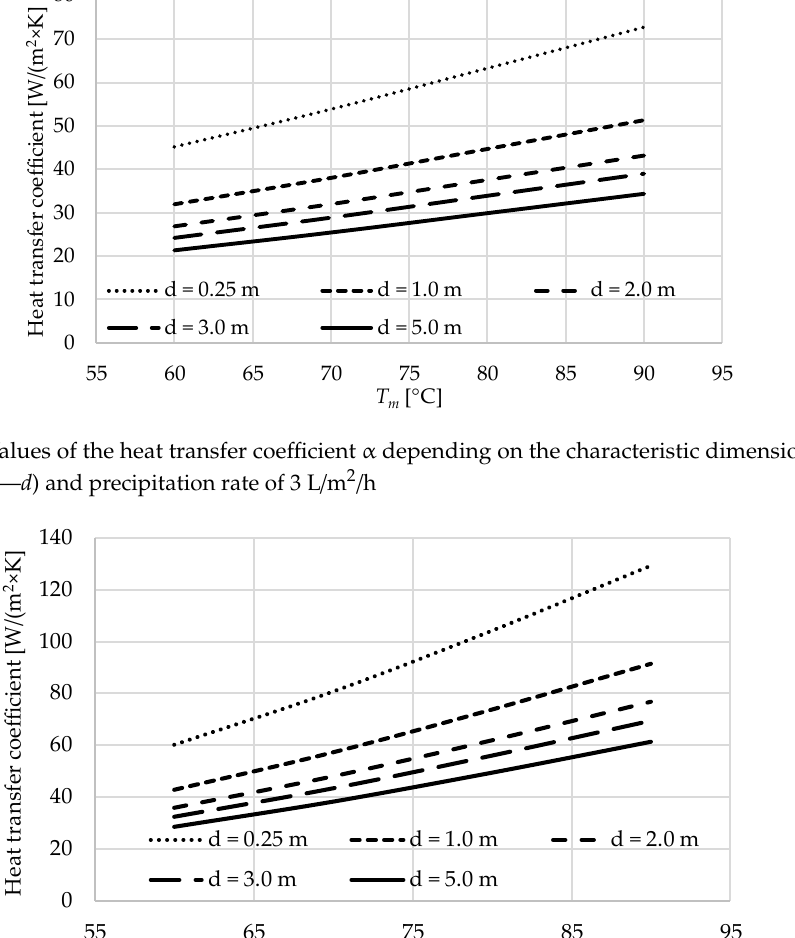
Table 6. Average deviation Ψ between the measured and theoretical temperatures in relations to the assumed time range for all analyzed samples.